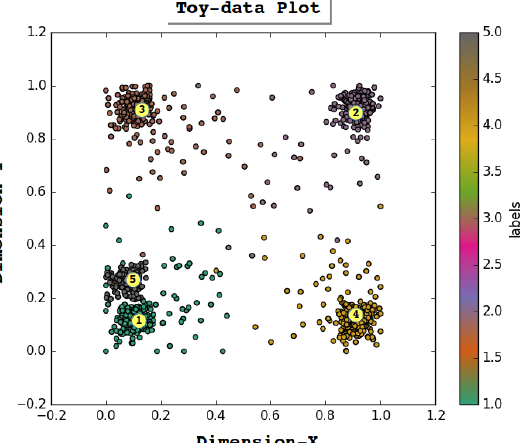
Figure 3. Graph of 2D Toy-data with five clusters, along with their respective cluster centers (1, ...,